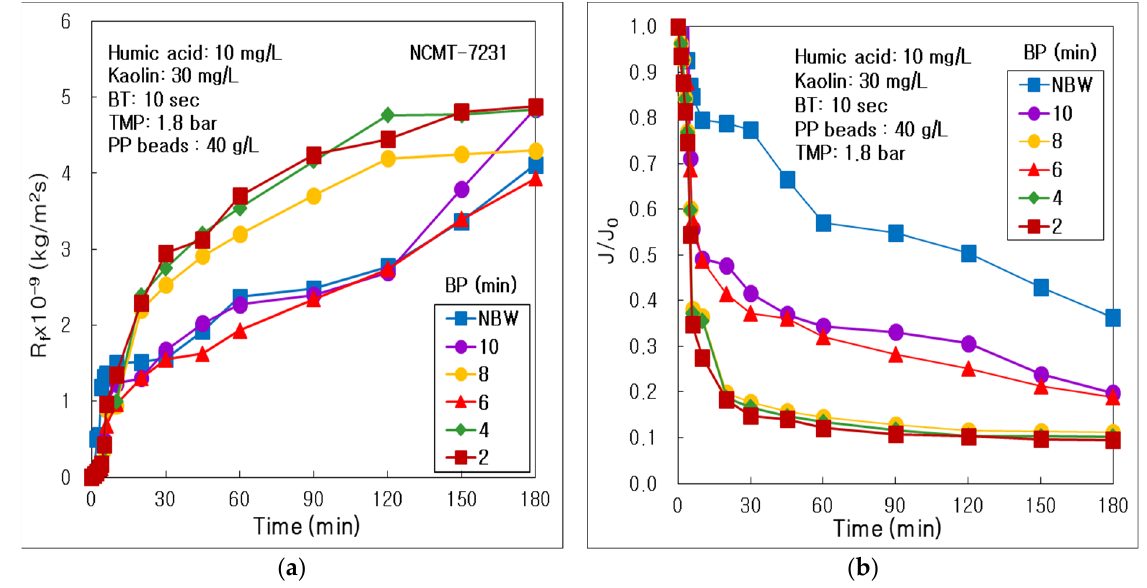
Figure 5. Influence of water backwashing period (BP) in the combined process of tubular alumina MF (NCMT-7231) and PP beads with UV irradiation and periodic water backwashing: ( a ) Resistance of membrane fouling; ( b ) Dimensionless permeate flux. Table 5. Influence of water backwashing period on filtration factors in the combined process of tubular alumina MF (NCMT-7231) membrane and PP beads with periodic water backwashing.